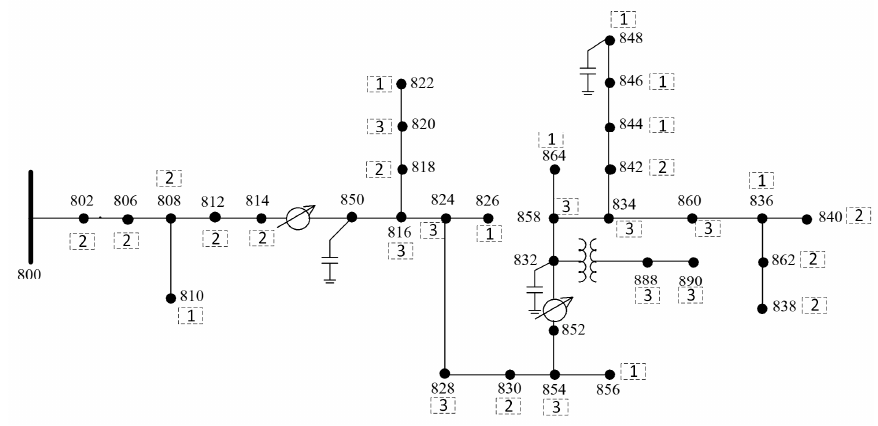
Figure 2. A Modified IEEE 34-bus system, numbers 1–3 indicate corresponding load curve for each bus.